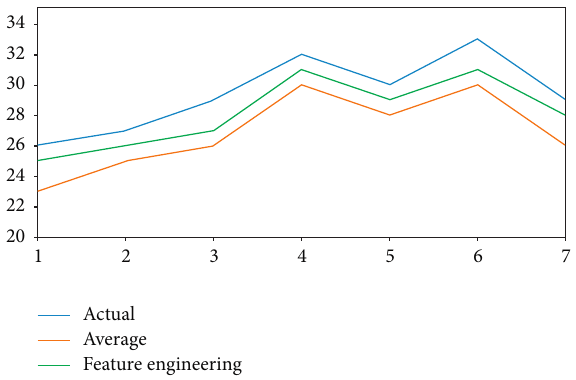
Figure 1: Feature